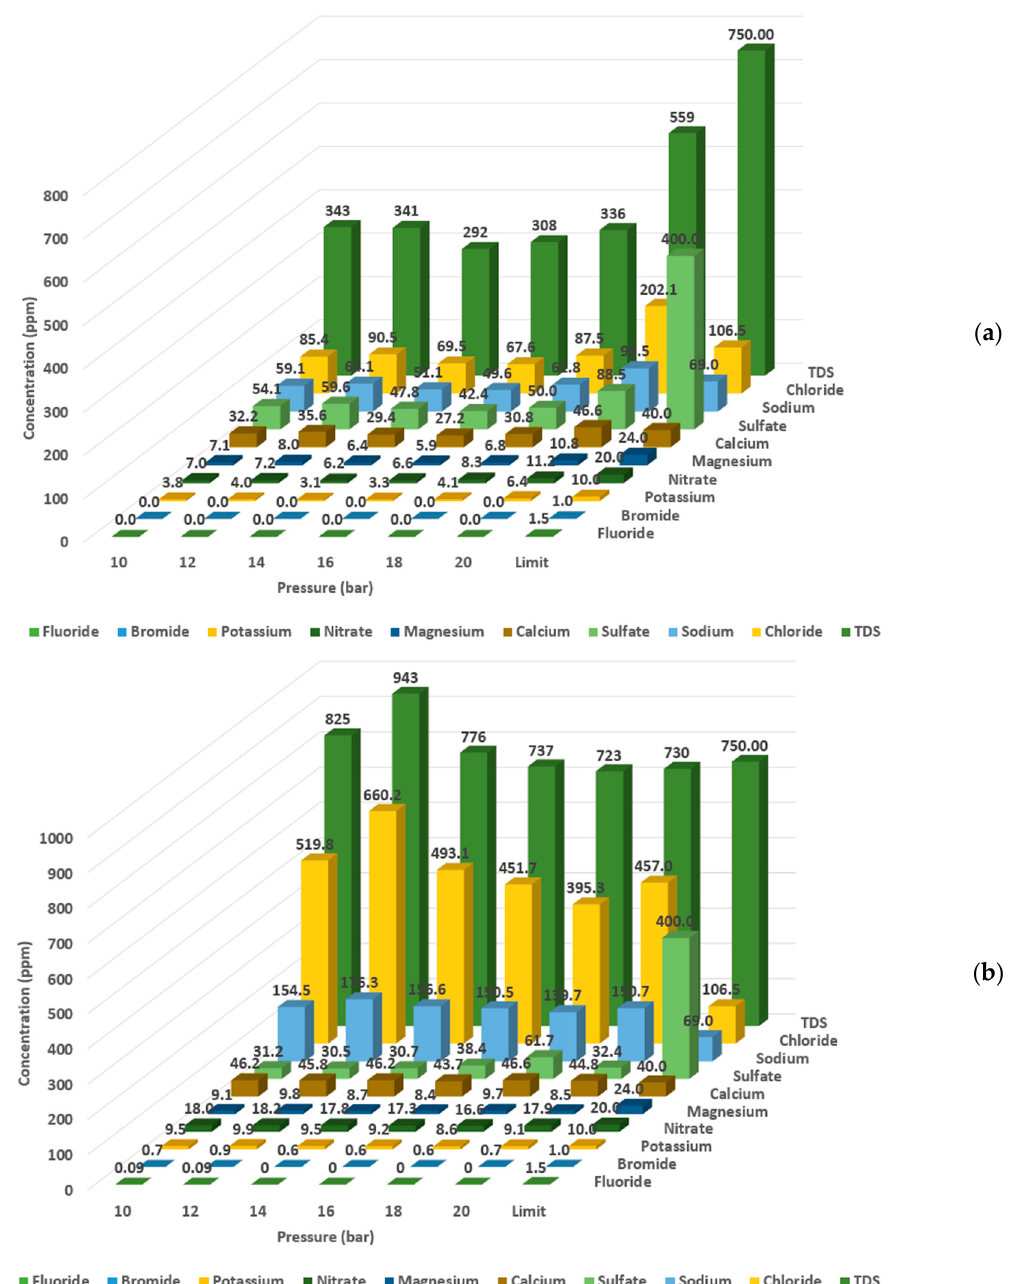
Figure 6. Characteristics of the permeate produced from treated sewage effluent (TSE) using ( a ) reverse osmosis ( b ) nanofiltration at different applied pressures.